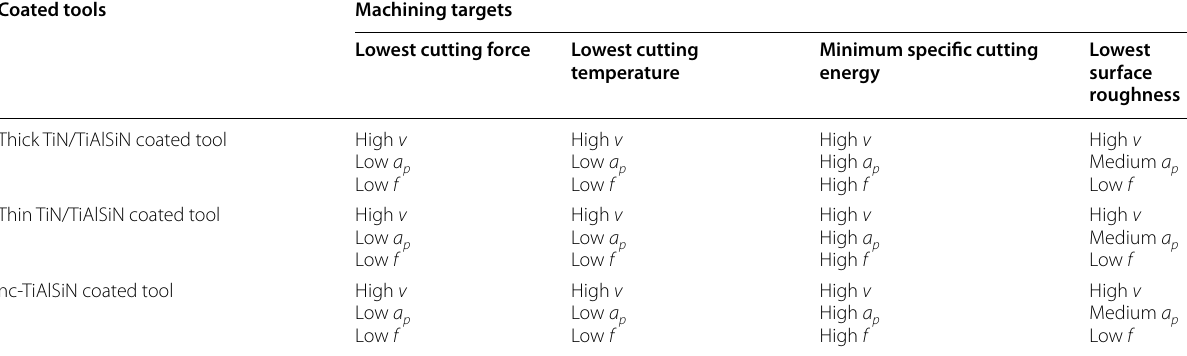
Table 6 Relationship between machining targets and cutting parameters of different coated tools Coated